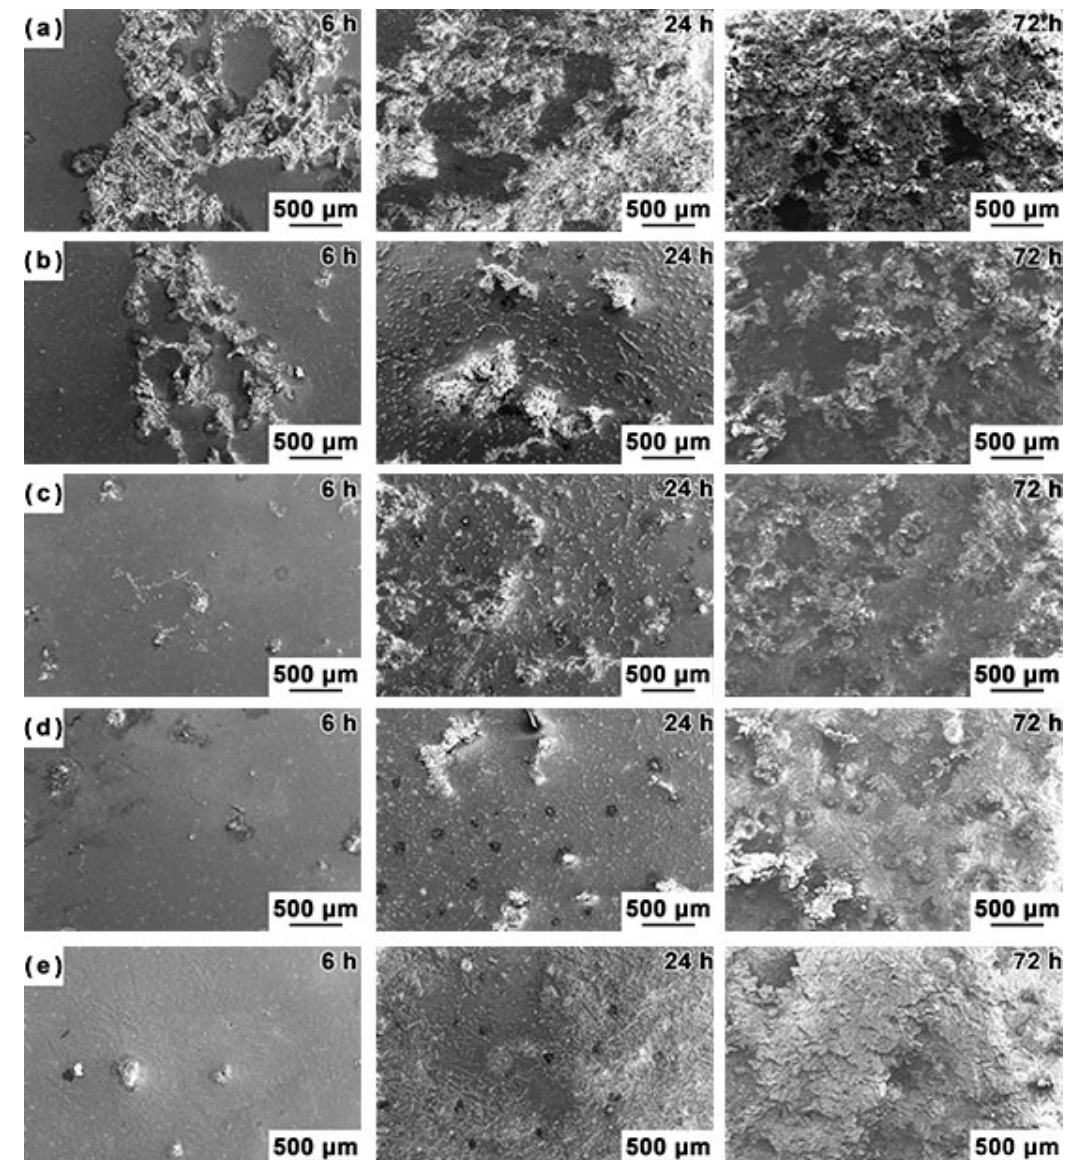
Figure 8. The evolution of the surface morphology of the investigated alloys after soaking for different durations in 3.5 wt % NaCl solution: ( a ) Mg–5Sn, ( b ) Mg–5Sn–0.5Ga, ( c ) Mg–5Sn–1Ga, ( d ) Mg–5Sn–2Ga, and ( e ) Mg–5Sn–3Ga, respectively.